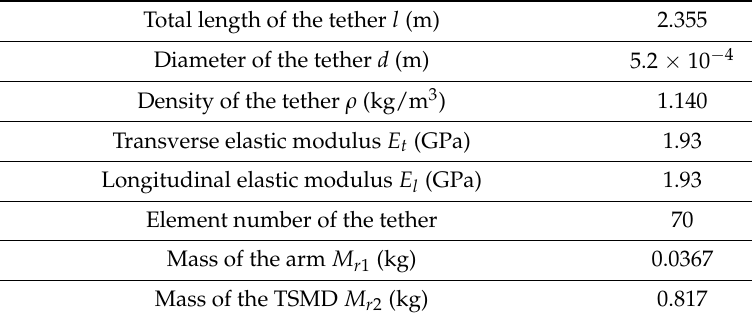
Figure 8. Initial experiment and analysis conditions. Table 1. Experimental equipment conditions.